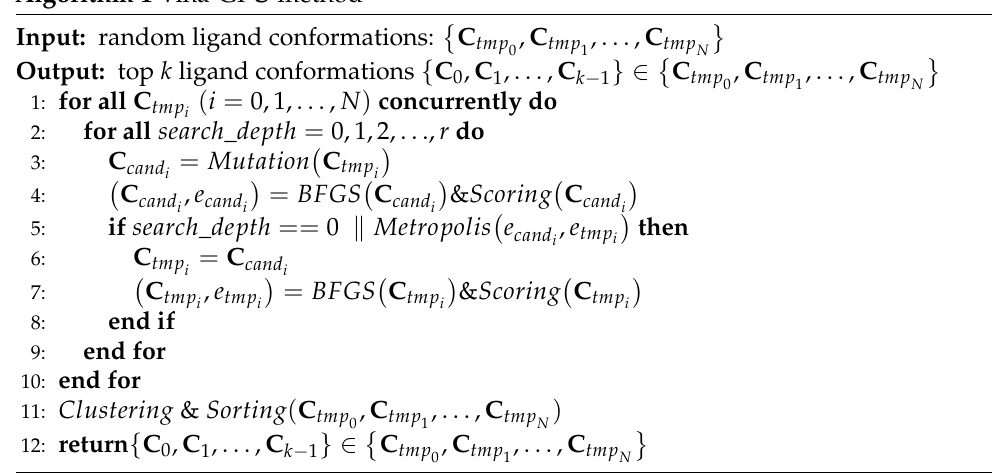
Algorithm 1 Vina-GPU